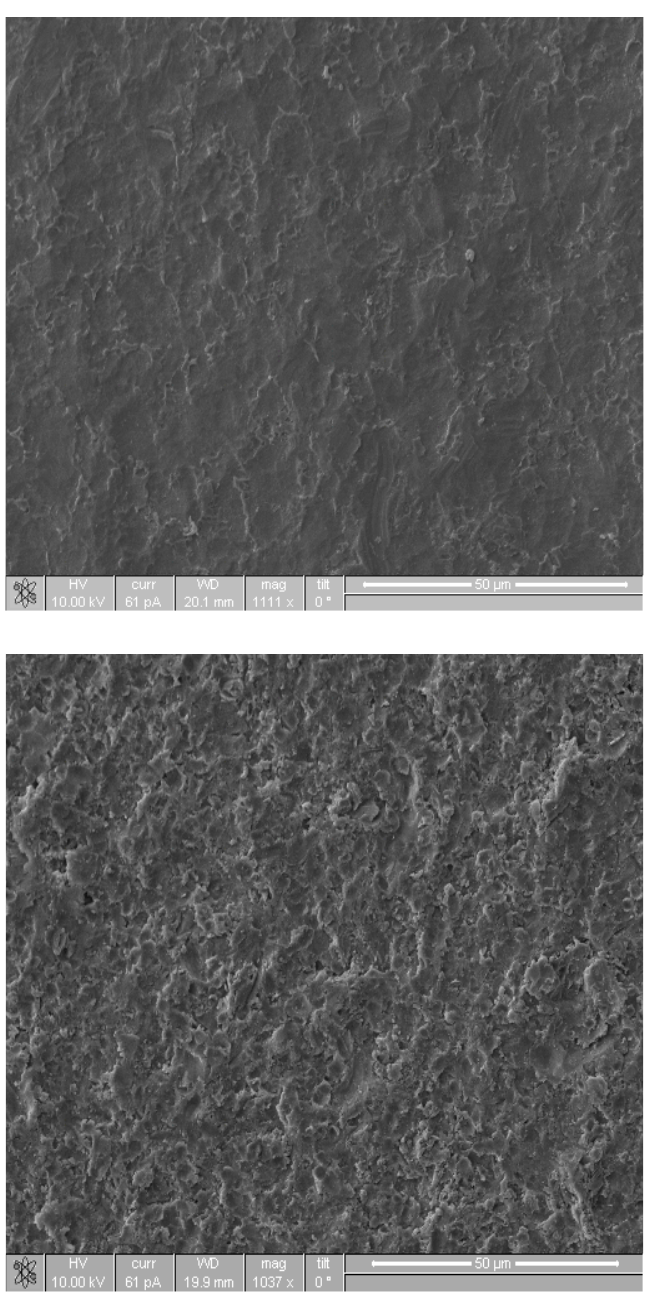
Figure 3. Scanning electron microscopy